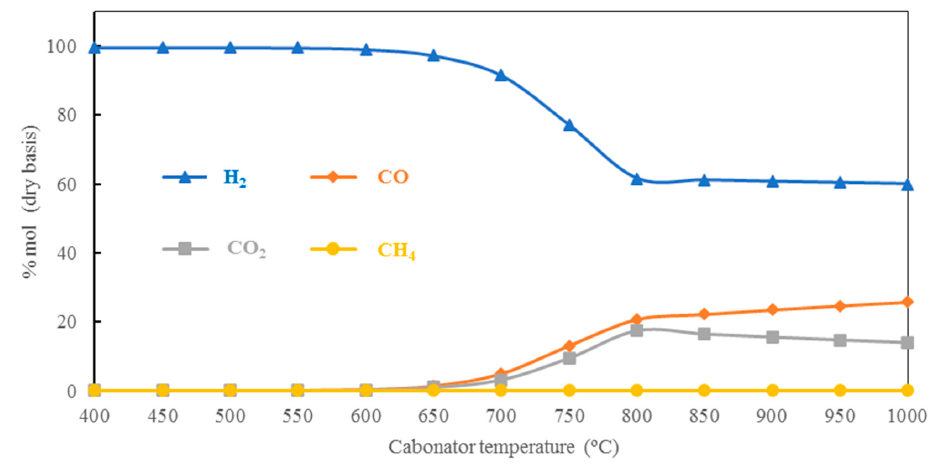
Figure 6. Effect of carbonator temperature on the gas product composition exited from a carbonator at a gasifier temperature = 700 °C, S/F mass ratio = 1, CaO/F mass ratio = 2, and regenerator temperature = 950 °C.